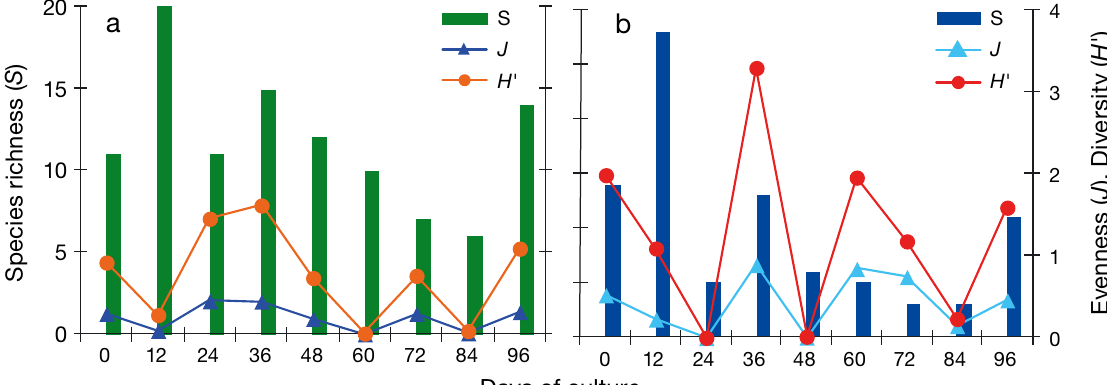
Fig. 5. Temporal variation in species diversity indices of (a) phytoplankton and (b) microzooplankton during the culture of Litopenaeus